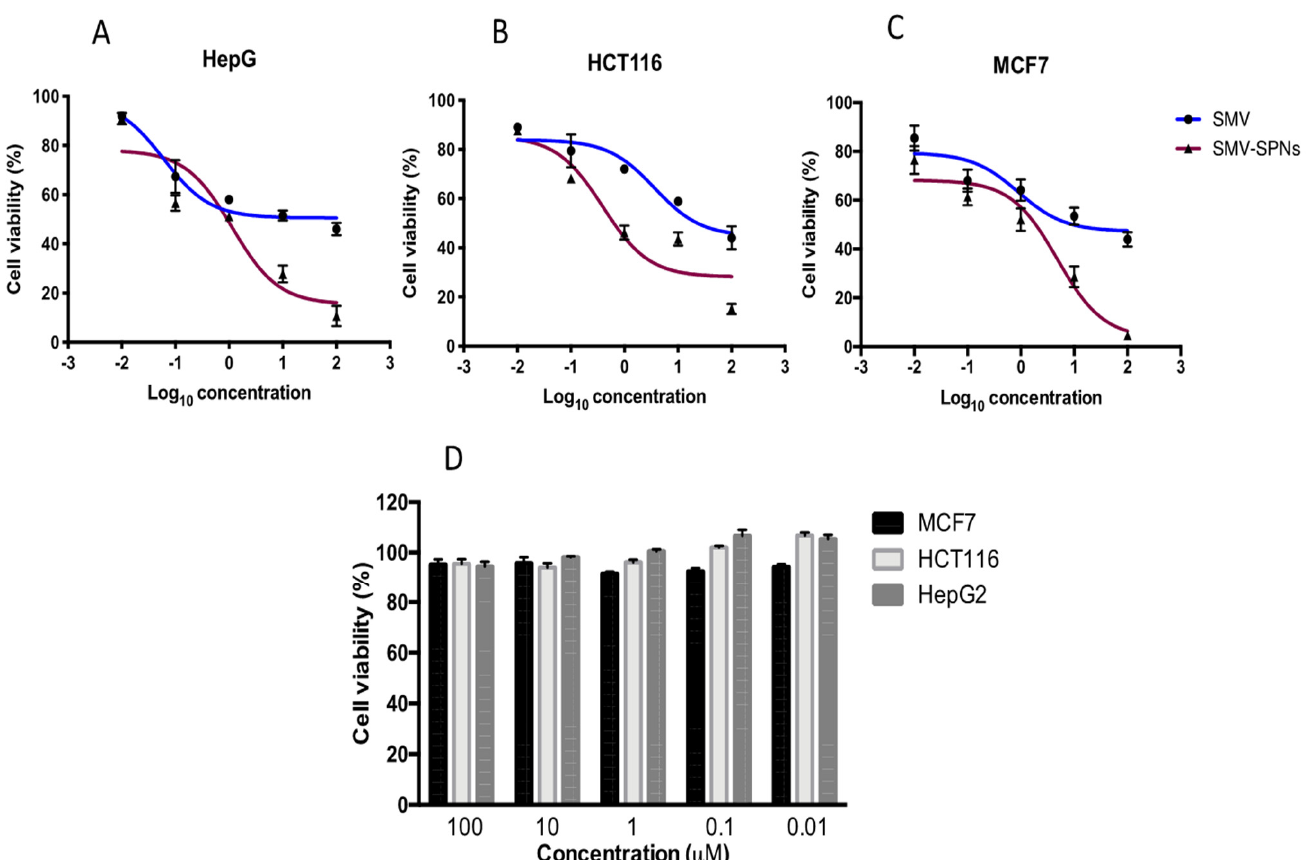
Figure 7. Cell viability evaluation using the MTT assay after 24 h of treatment with SMVor SMV-SPNs ( A ) MCF-7 ( B ) HCT-116 ( C ) HEPG2 cells ( D ) cell viablitiy after 24 h of treatment with blank-SPNs. Data are expressed as the mean ± SEM ( n = 3). Abbreviations: SMV, simvastatin; SPNs; spanlastics.